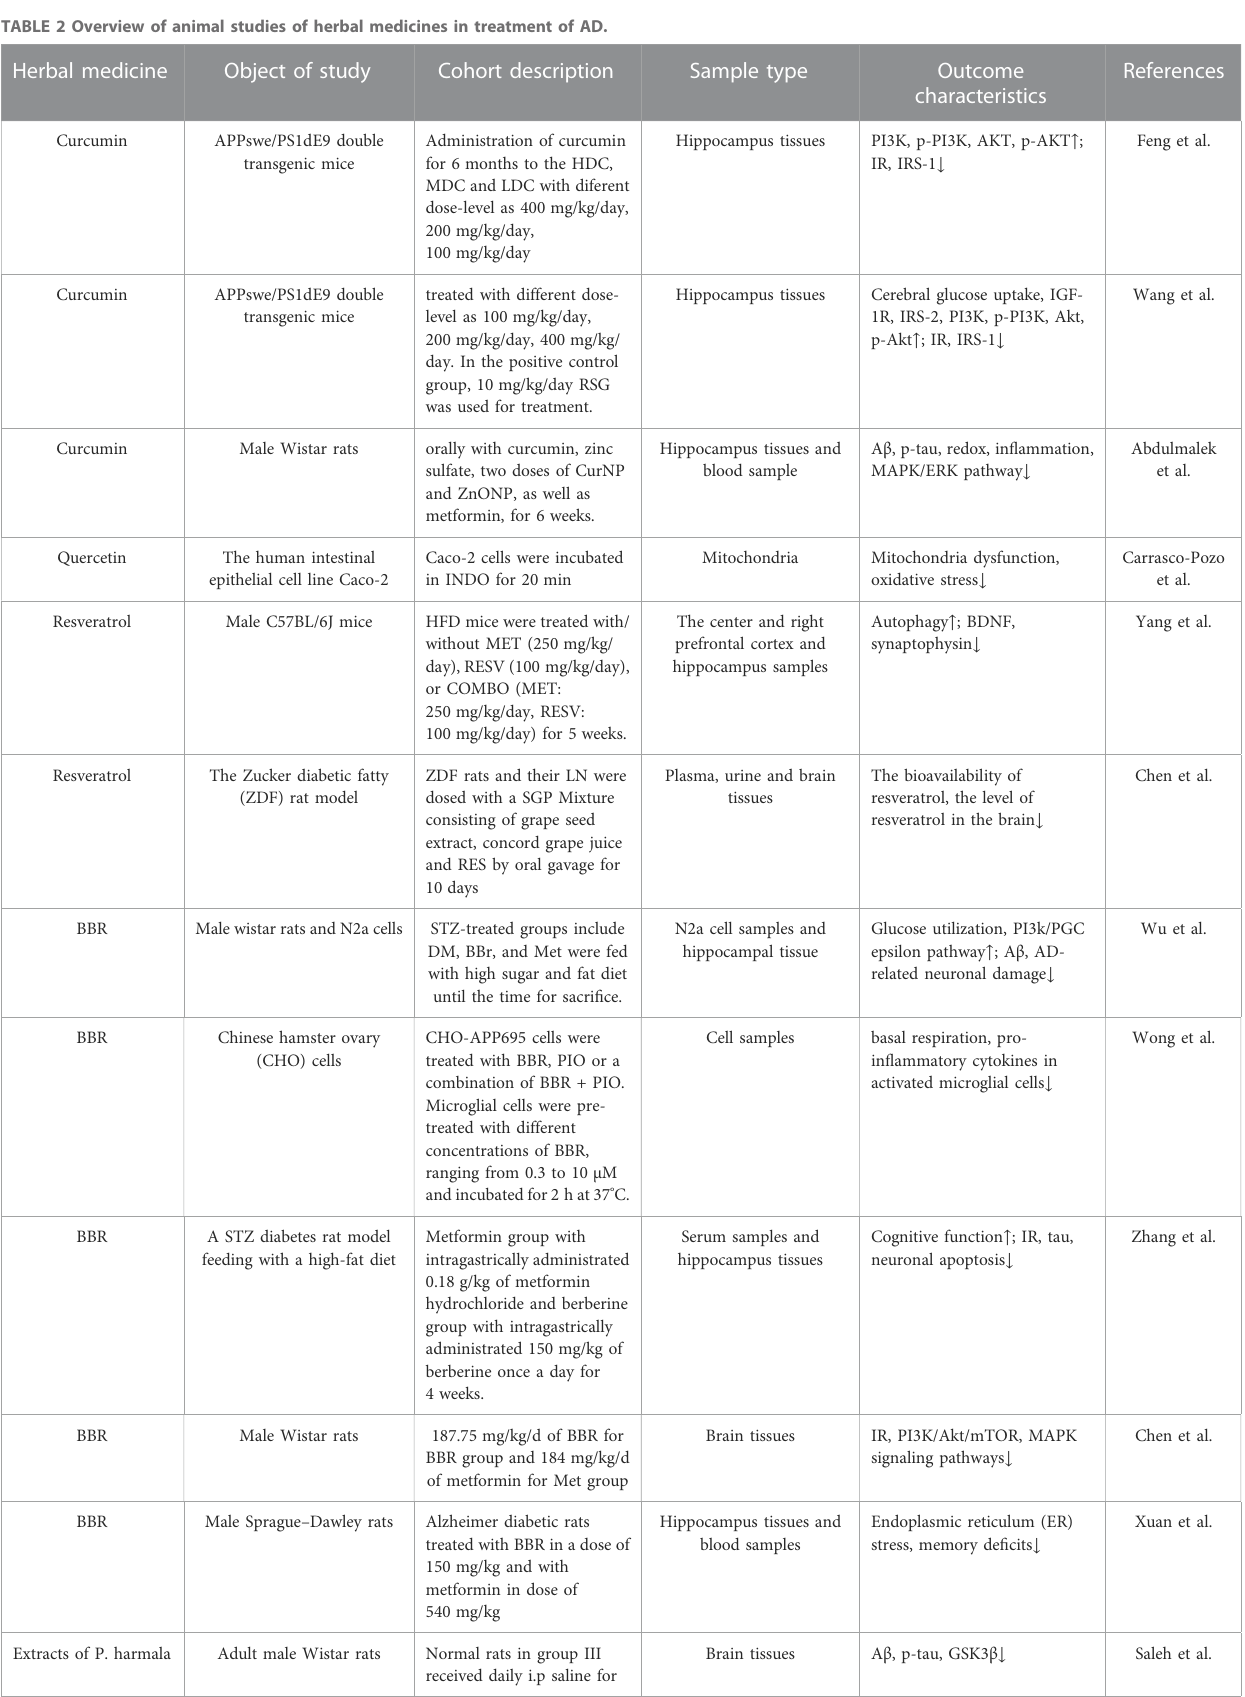
TABLE 2 Overview of animal studies of herbal medicines in treatment of AD. Herbal